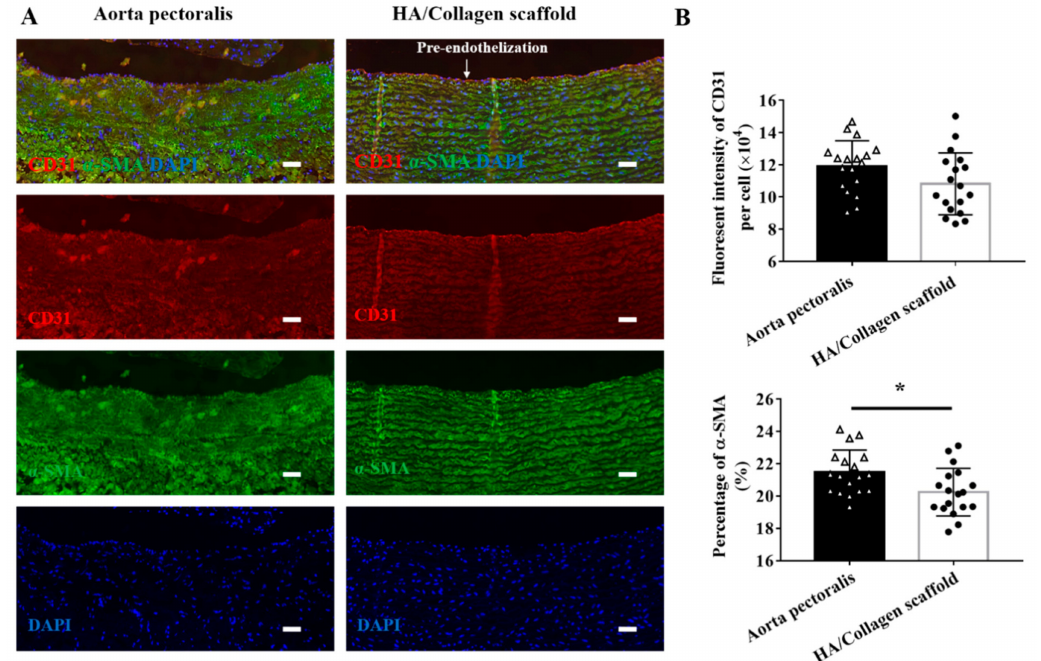
Figure 8. Fluorescence immunostaining. ( A ) Representative CLSM micrographs of rabbit native aorta and cellularized tubular HA/collagen scaffold. Nucleus (blue), CD31 in vascular EC (red), α -SMA in vascular SMC (green). Scale bars: 60 µ m. ( B ) Statistical data of CD31 and α -SMA fluorescence of rabbit native aorta and cellularized tubular HA/collagen scaffolds. * p <